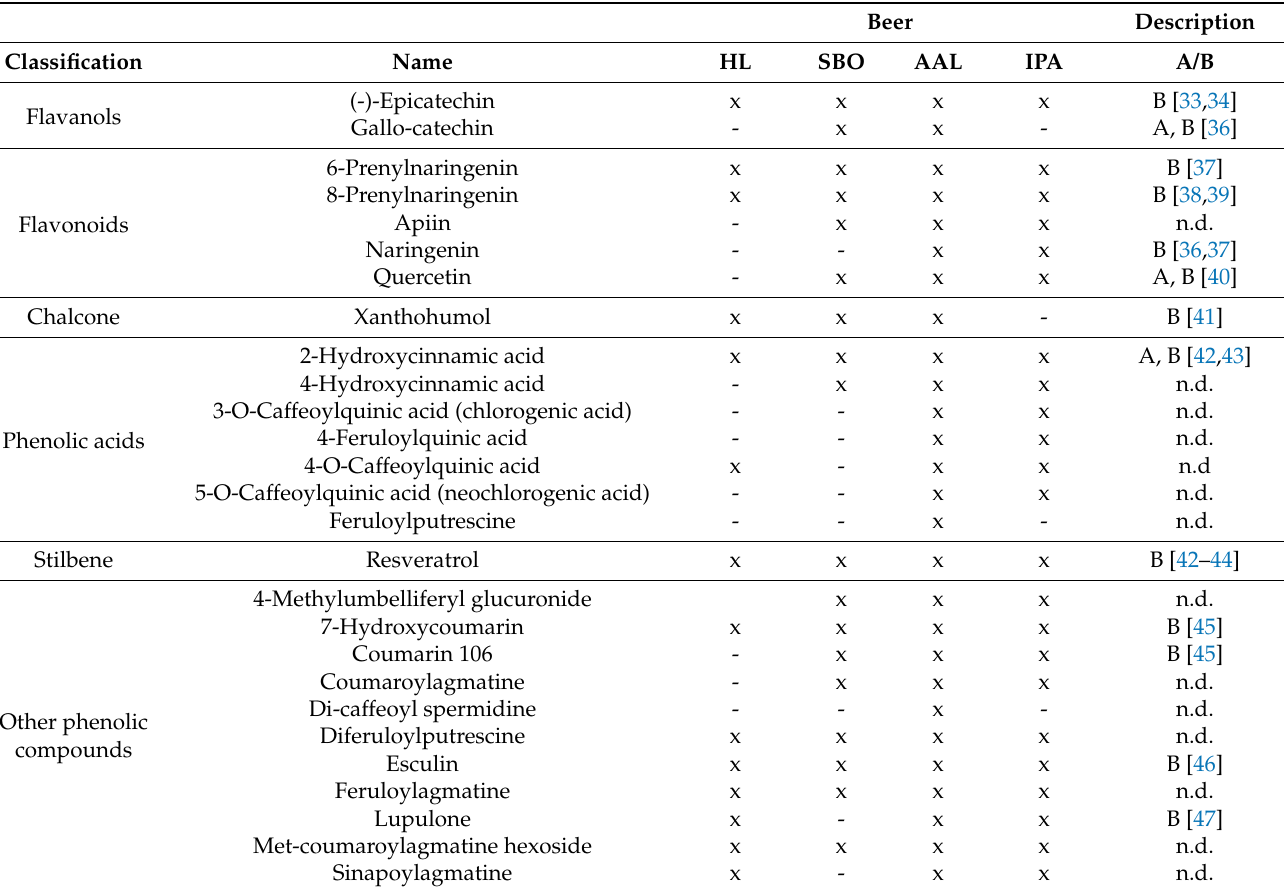
Table 3. Phenolic compounds present in the analyzed beers and their taste quality description. “A/B” description indicates astringency (A) and bitterness (B)